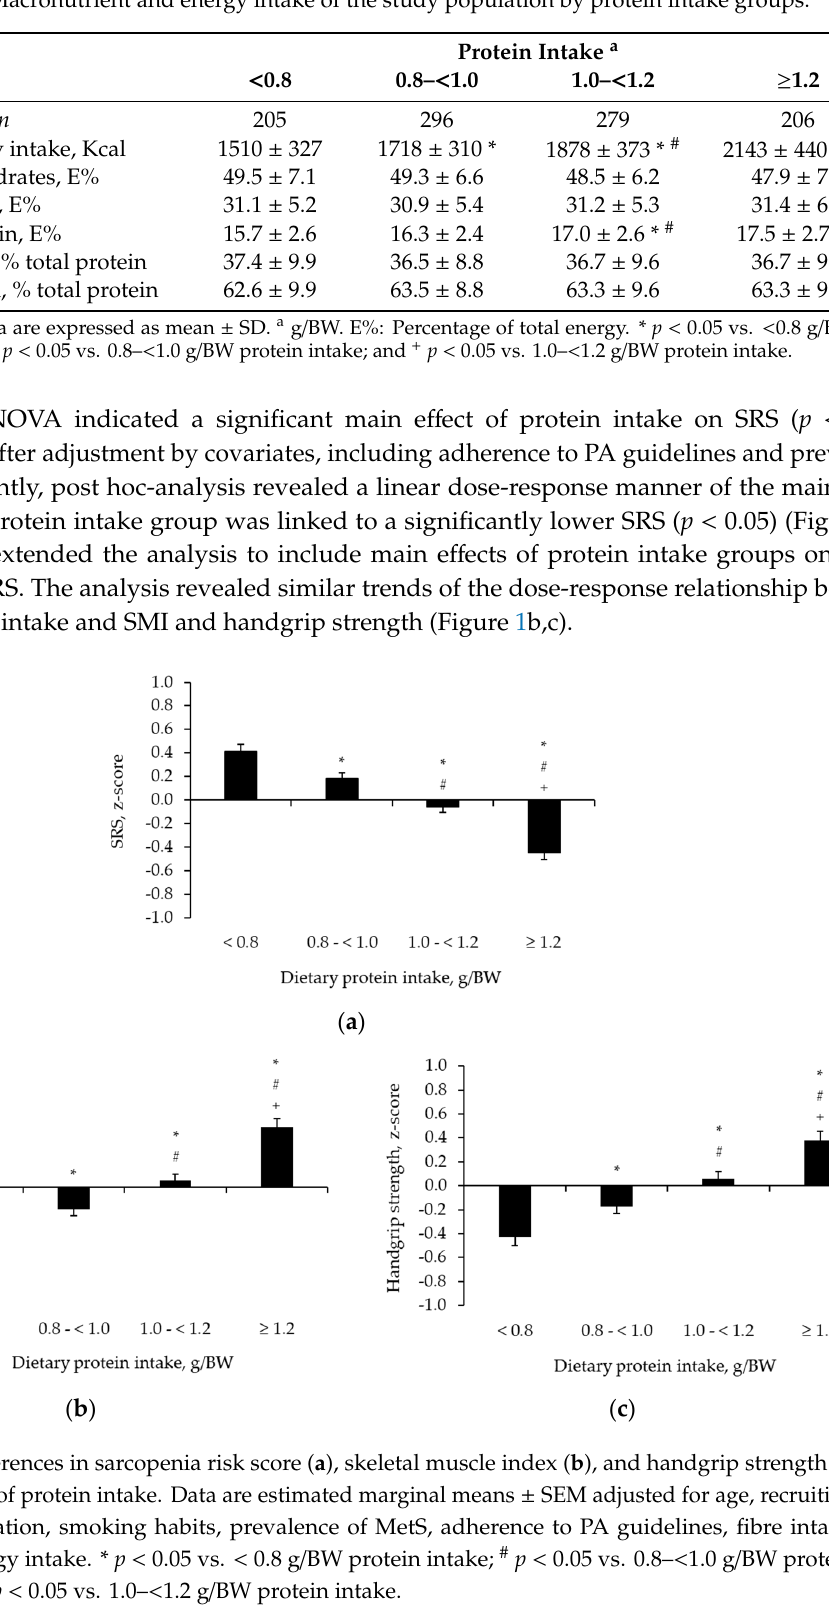
Table 2. Macronutrient and energy intake of the study population by protein intake groups.